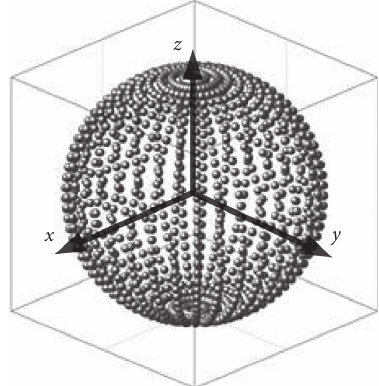
Figure 4: Discrete workspace of the